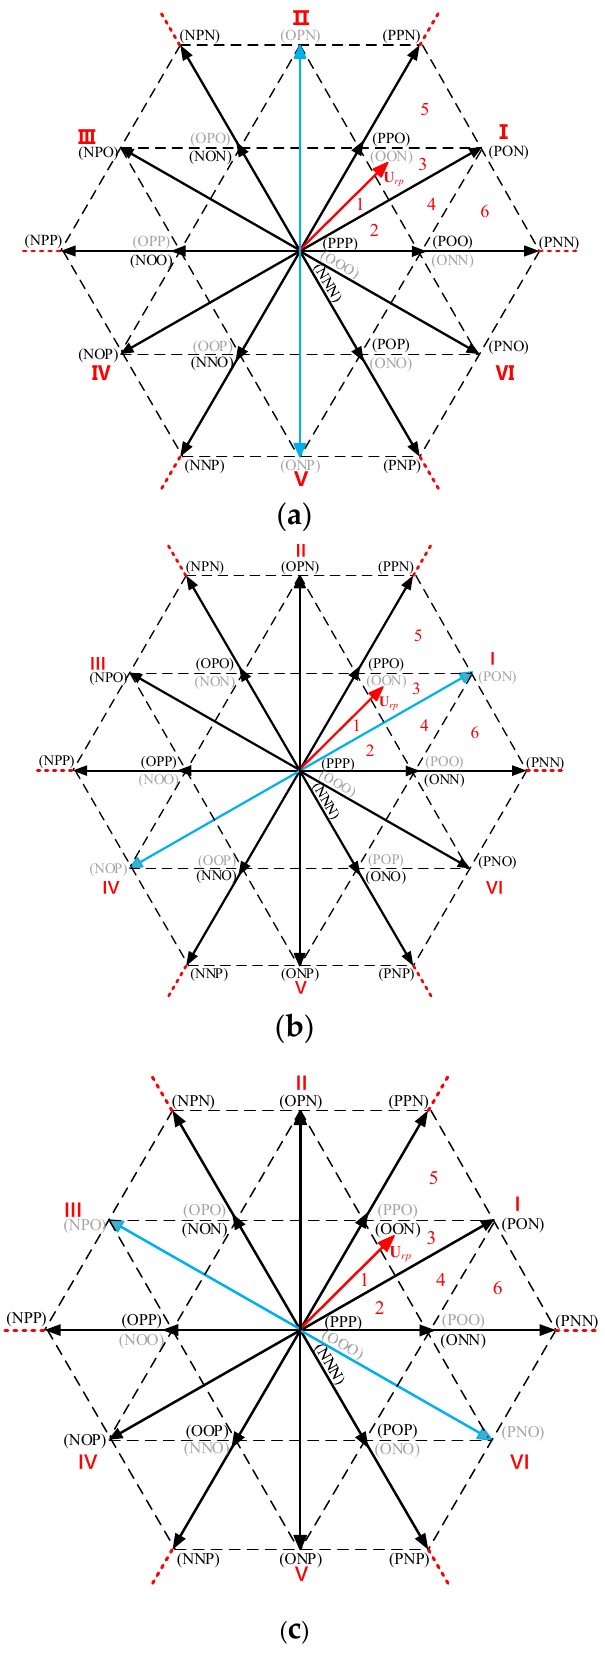
Figure 5. Space vector diagram of typical fault types ( a ) type u ( b ) type v and ( c ) type w.